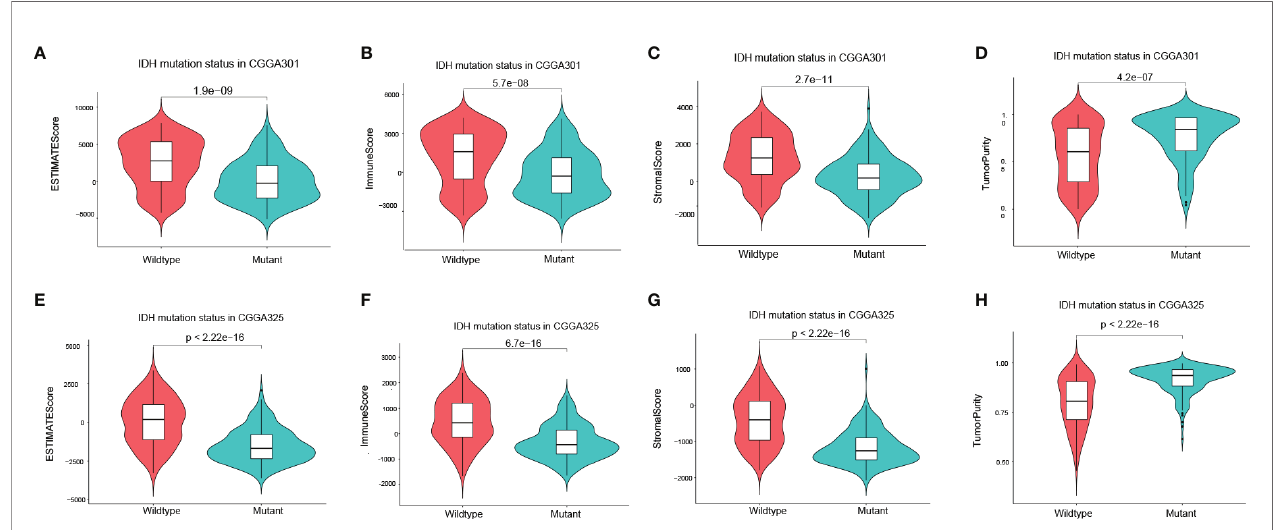
FIGURE 6 | Correlation of the IDH mutation status with the tumor environment. (A – H) Violin plot showed the four differential scores (EstimateScore, ImmuneScore, StromalScore, TumorPurity) between IDH wildtype and mutation glioma samples by using the ESTIMATE algorithm in CGGA301 and CGGA325 datasets,